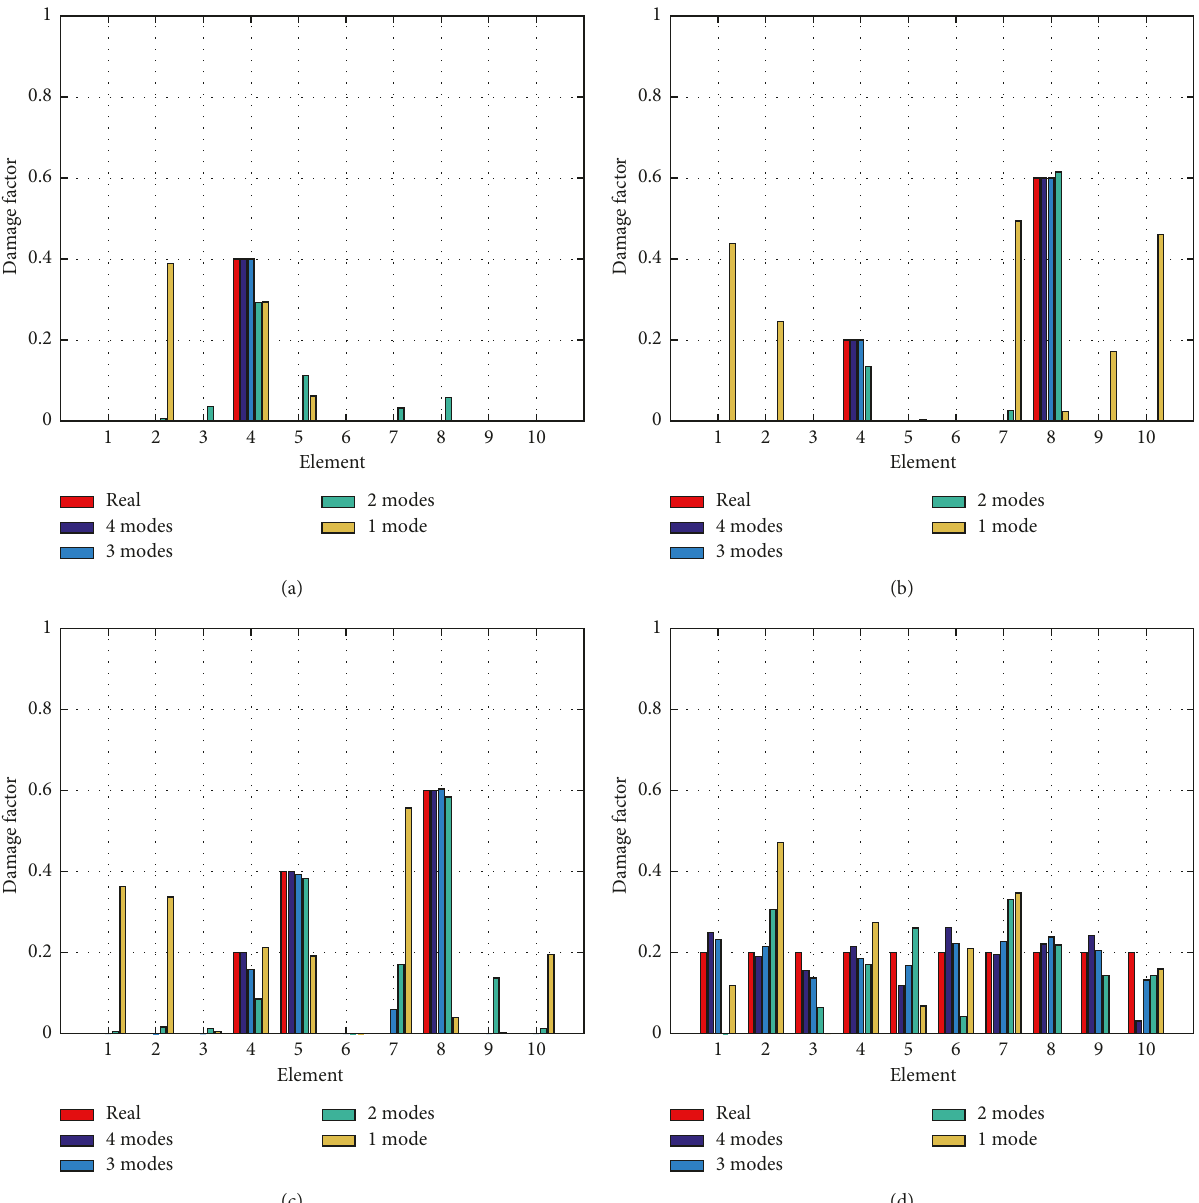
Figure 8: Beam example: performance of the combined criterion for different damage scenarios (noise 10%). (a) Scenario 1, (b) scenario 2, (c) scenario 3, and (d) scenario 4. Table 3: Beam example: norm values for different damage scenarios and 1 to 4 known modes (noise 10%). Known modes